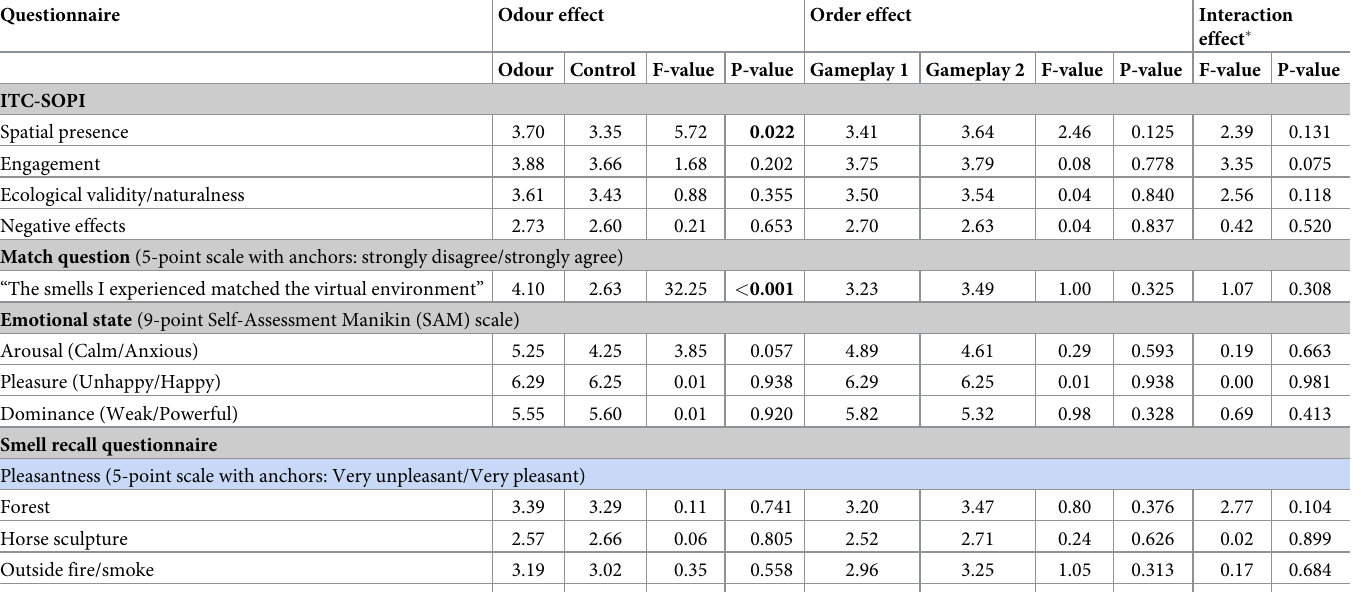
Table 3. Effect of odour addition and order of gameplay on post gameplay questionnaire measures.